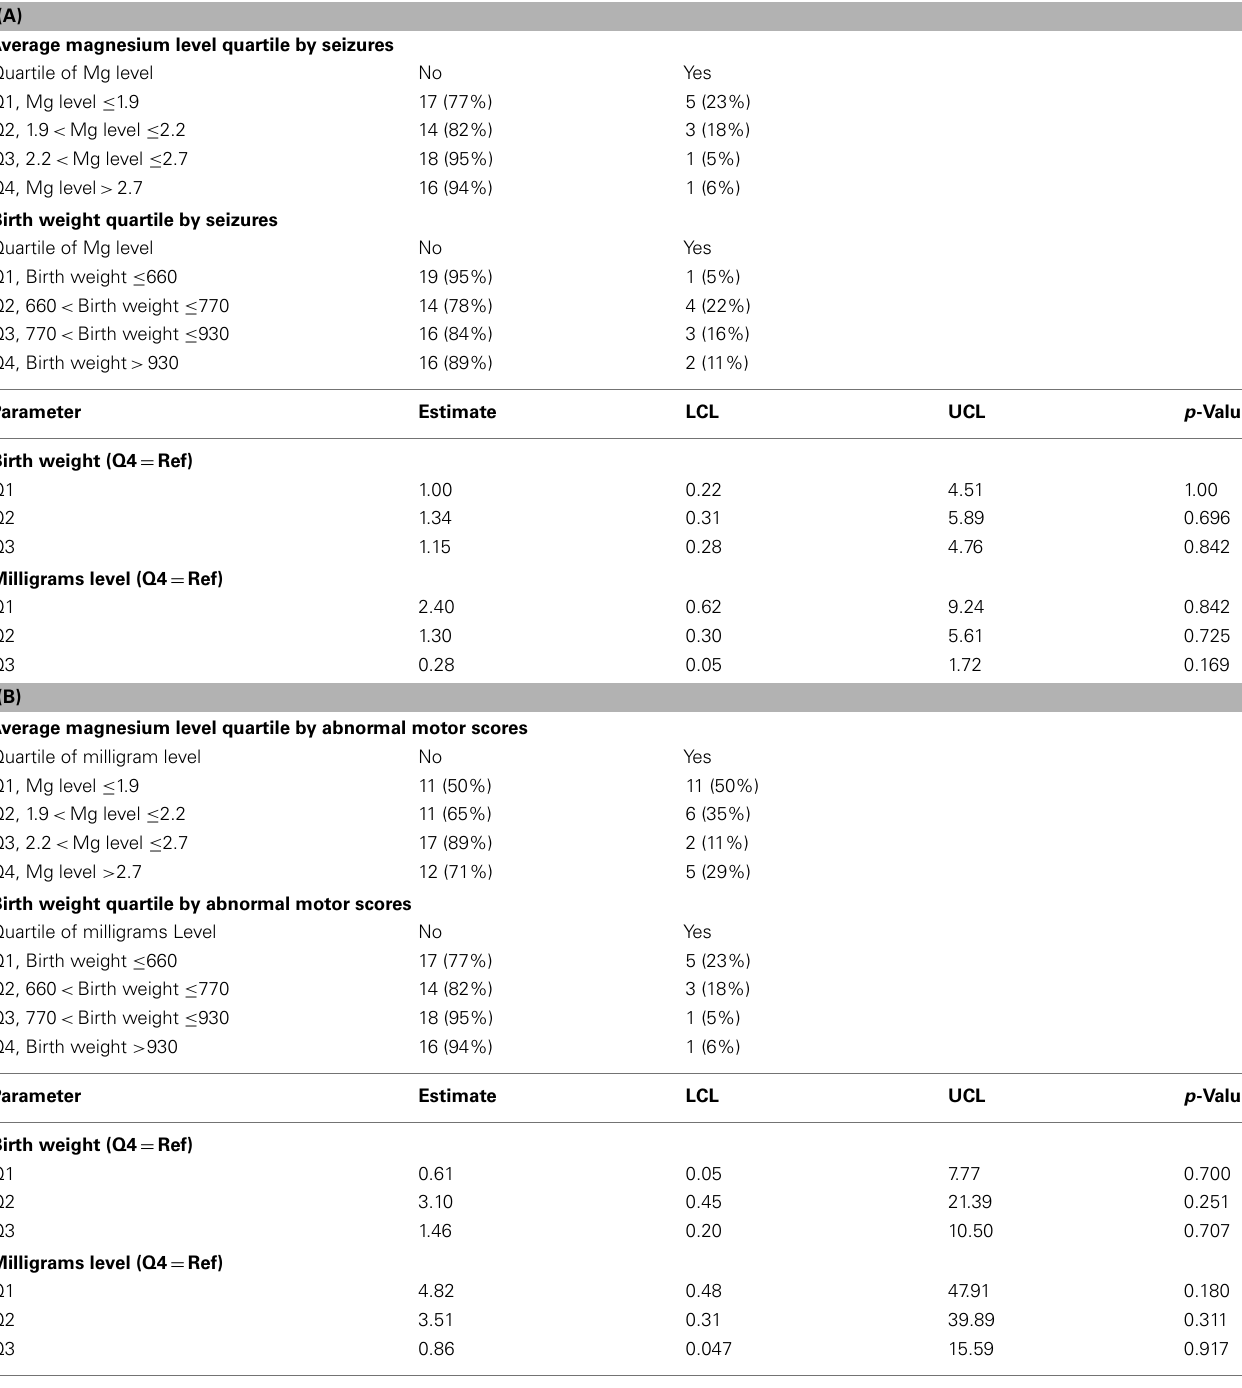
Table 5 | Logistic regression results; (A) Multivariable regression analysis for the outcome of seizures, analyzed for birth weight and magnesium levels; (B) Multivariable regression analysis for the outcome of abnormal motor exam, analyzed for birth weight, and magnesium levels